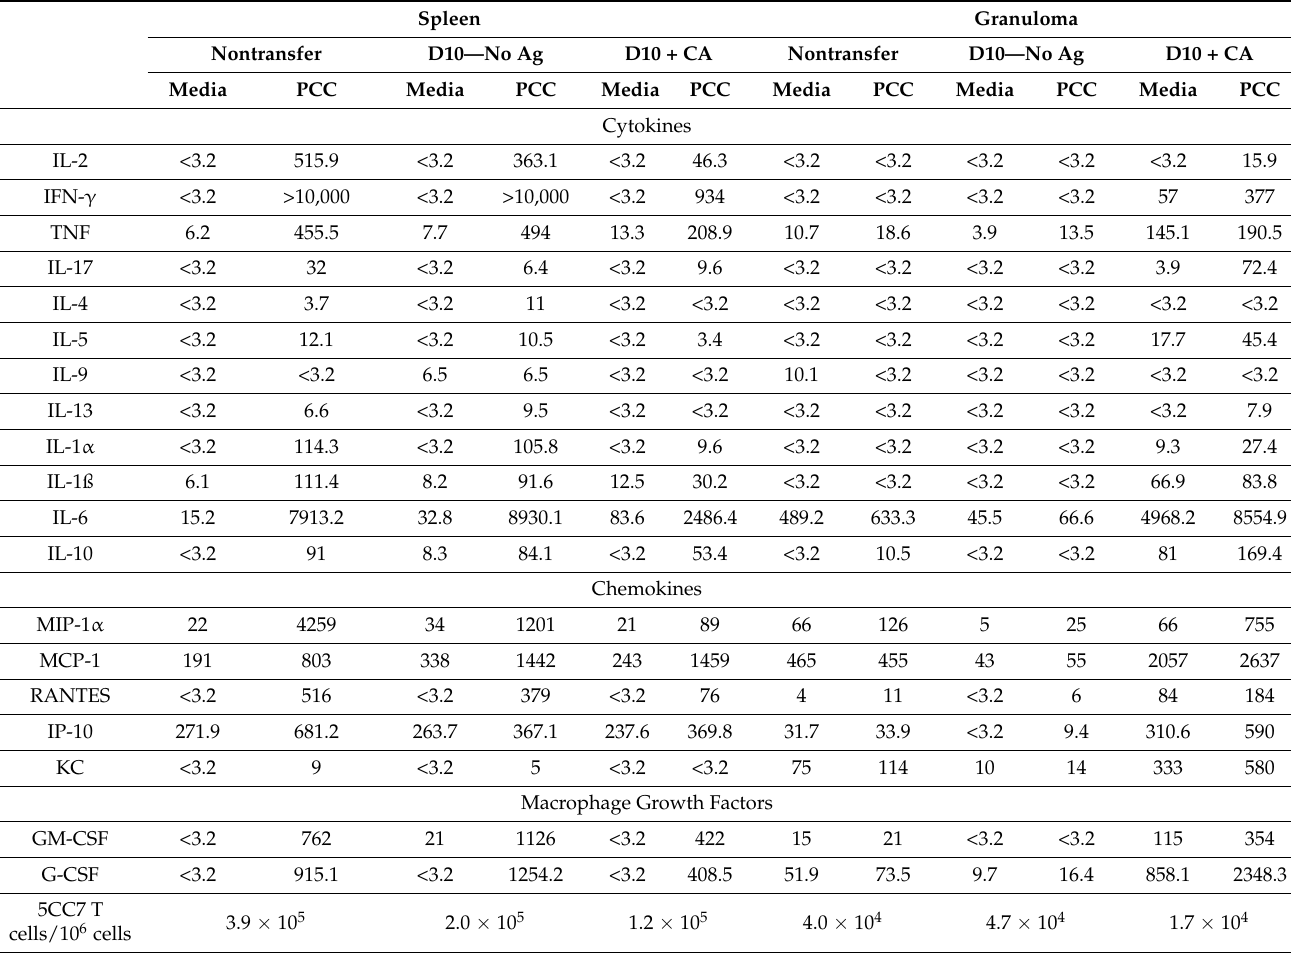
Table 2. Activation of non-Specific T cells Rescues the Anergic Cytokine and Chemokine Secretion Profile of Chronically Activated BCG-Specific T Cells 1